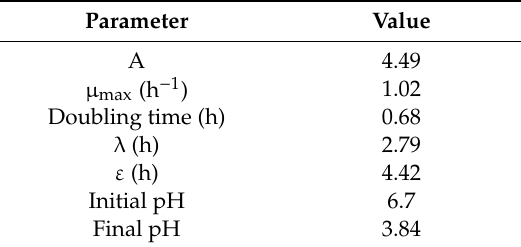
Figure 3. Lactobacillus leichmannii 313 growth and enzyme activity. Bacteria were grown at 37 °C and 0 rpm, in 20 mL of MRS broth placed in 30 mL capacity universal media glass bottles. Results are shown as the mean ± standard deviation of three independent experiments. Table 5. Bacterial growth curve parameters